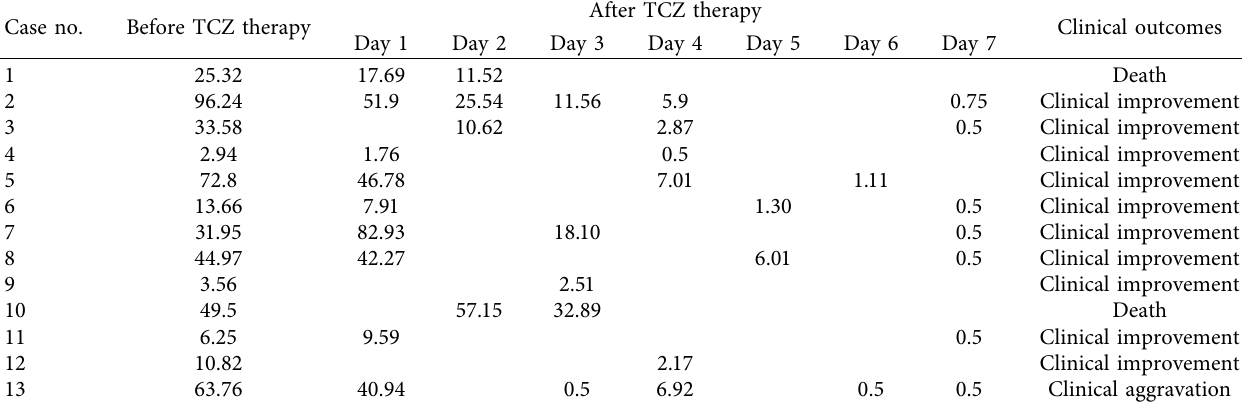
Table 3: The CRP levels of COVID-19 patients before and after TCZ treatment (mg/L). Case no.